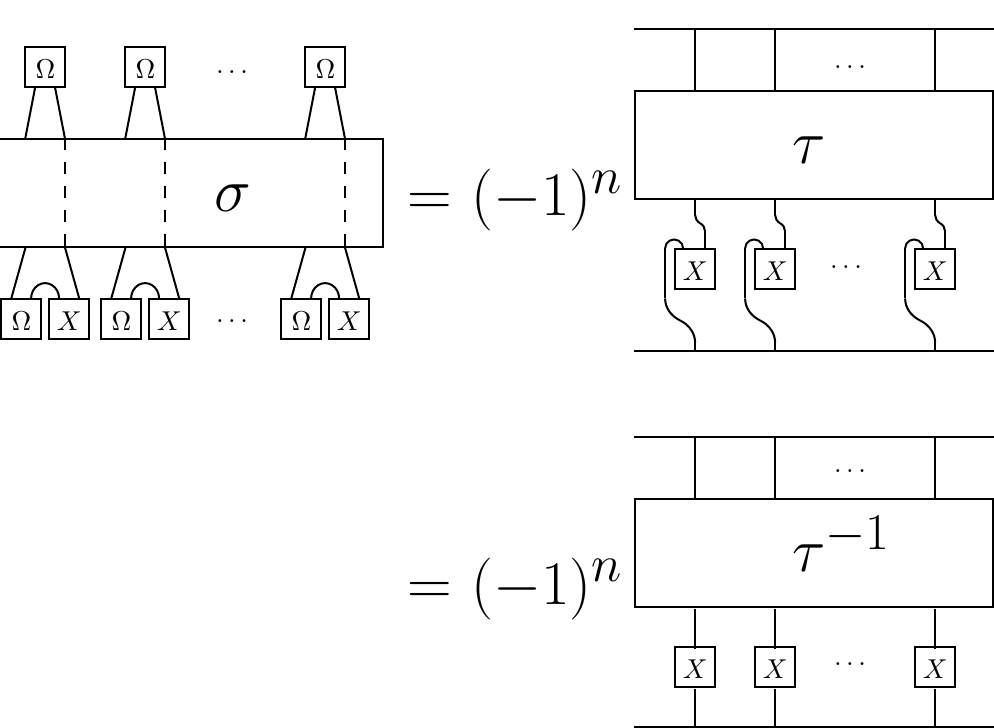
Figure 13 . A diagrammatic version of (9.19). The dotted lines represent the fact that (cid:27) (cid:12)xes all even numbers. By following the index contractions on the left, we see that (cid:28) should be contracted with n copies of the matrix (cid:10) X (cid:10) T . Using the condition (9.1), this is just (cid:0) X T . We have pulled out the factors of (cid:0) 1 and the transpose means the X indices switch roles (compare with (cid:12)gure 5). In the second row, we convert this result into a U( N ) type contraction by breaking our index conventions and setting X i = X ij . Note that the role switch of the X indices on the (cid:12)rst line means (cid:28) is j inverted on the second